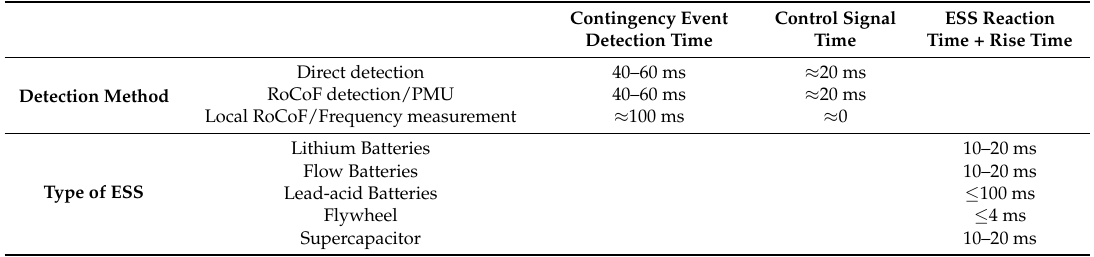
Table 1. Response times of various detection methods and types of energy storage systems (ESS)